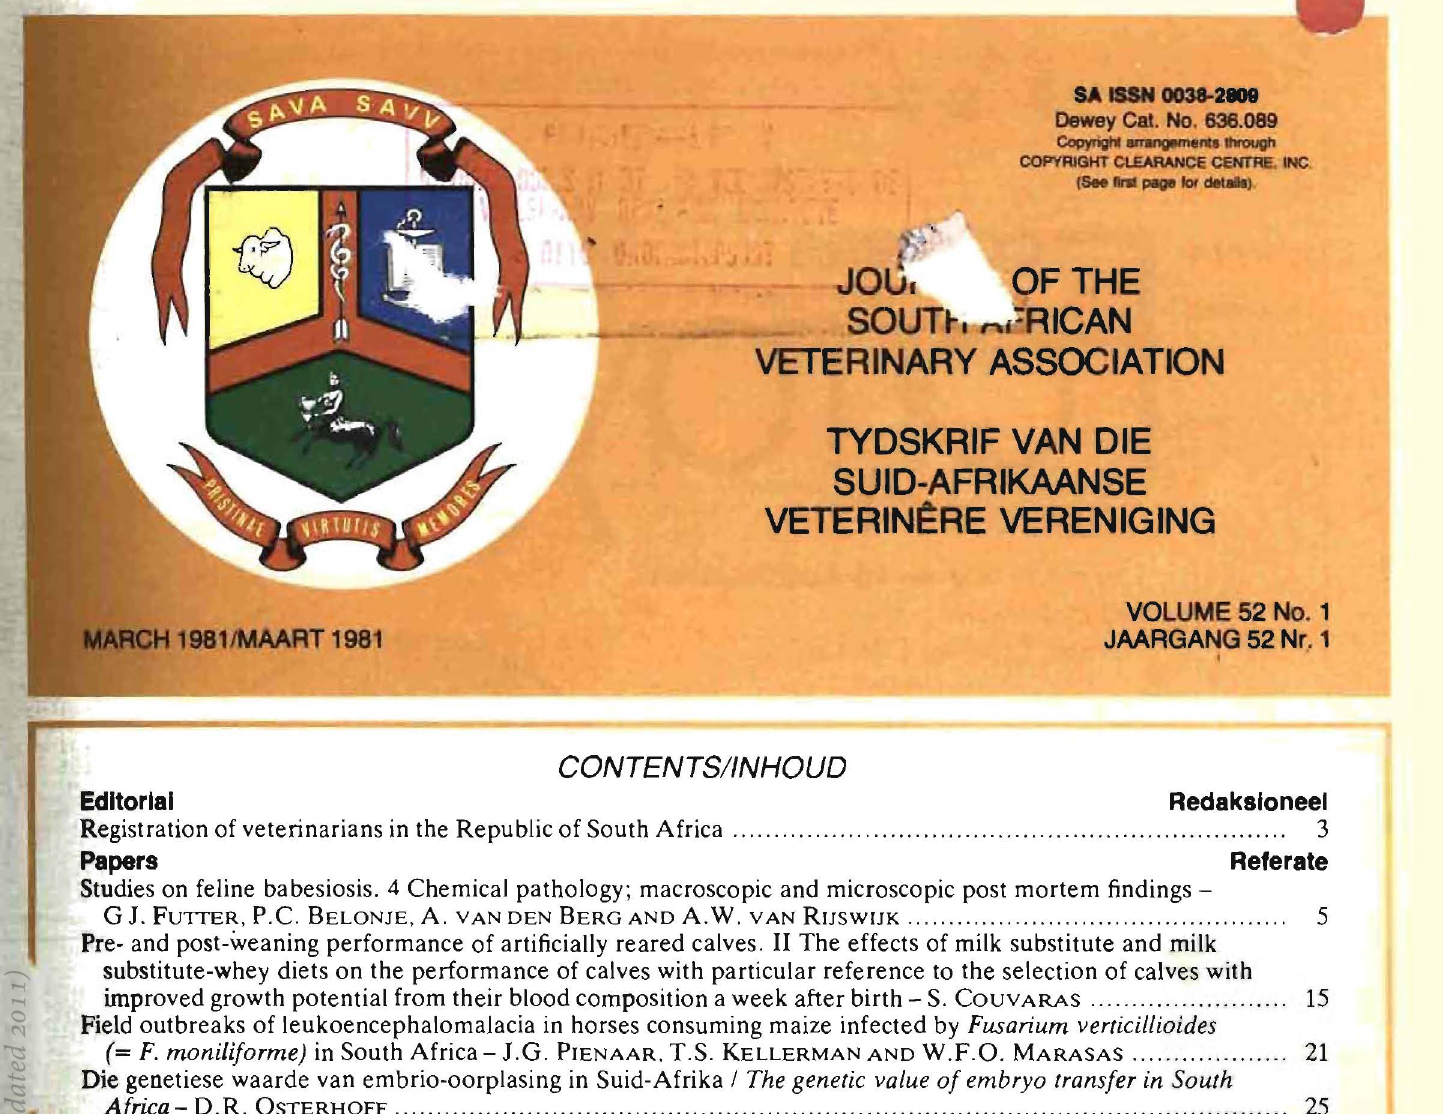
Studies on feline babesiosis. 4 Chemical pathology; macroscopic and microscopic post mortem findings - Pre- and post-weaning performance of artificially reared calves. II The effects of milk substitute and